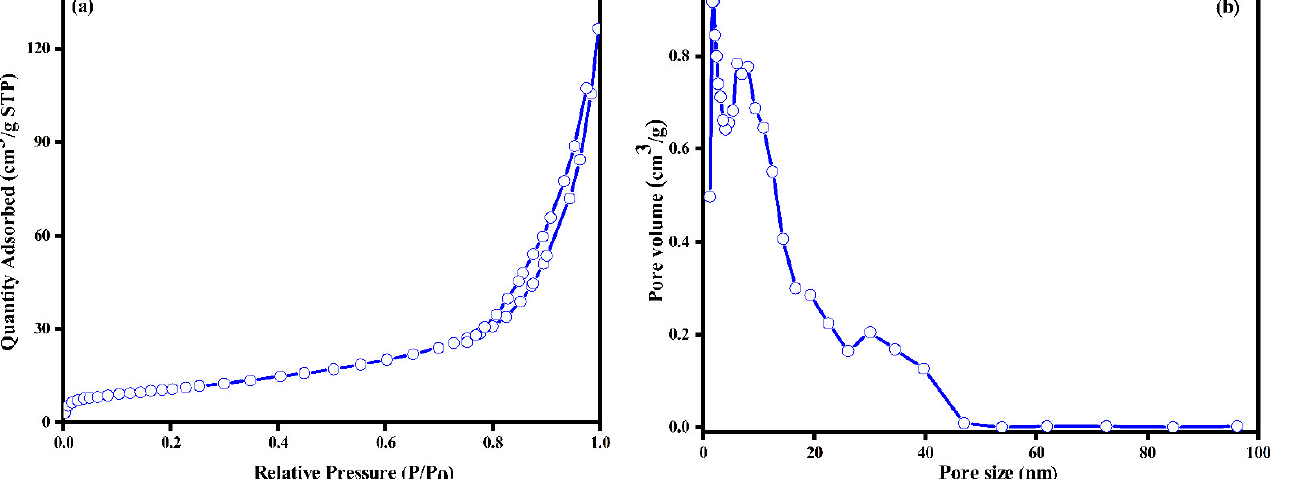
Figure 2. X-ray diffraction (XRD) patterns of zeolite-incorporated agar/cellulose/PVA biomembrane and corresponding ZSM-5 zeolite (inset).